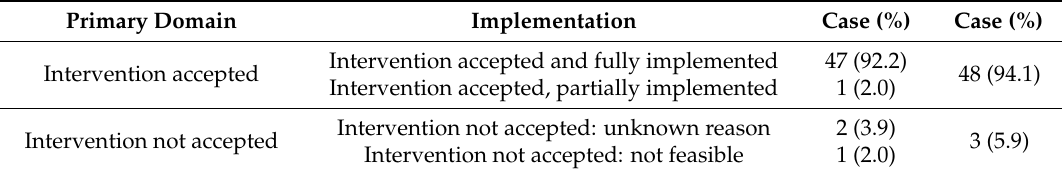
Table 4. Acceptance of pharmacist interventions in the intervention